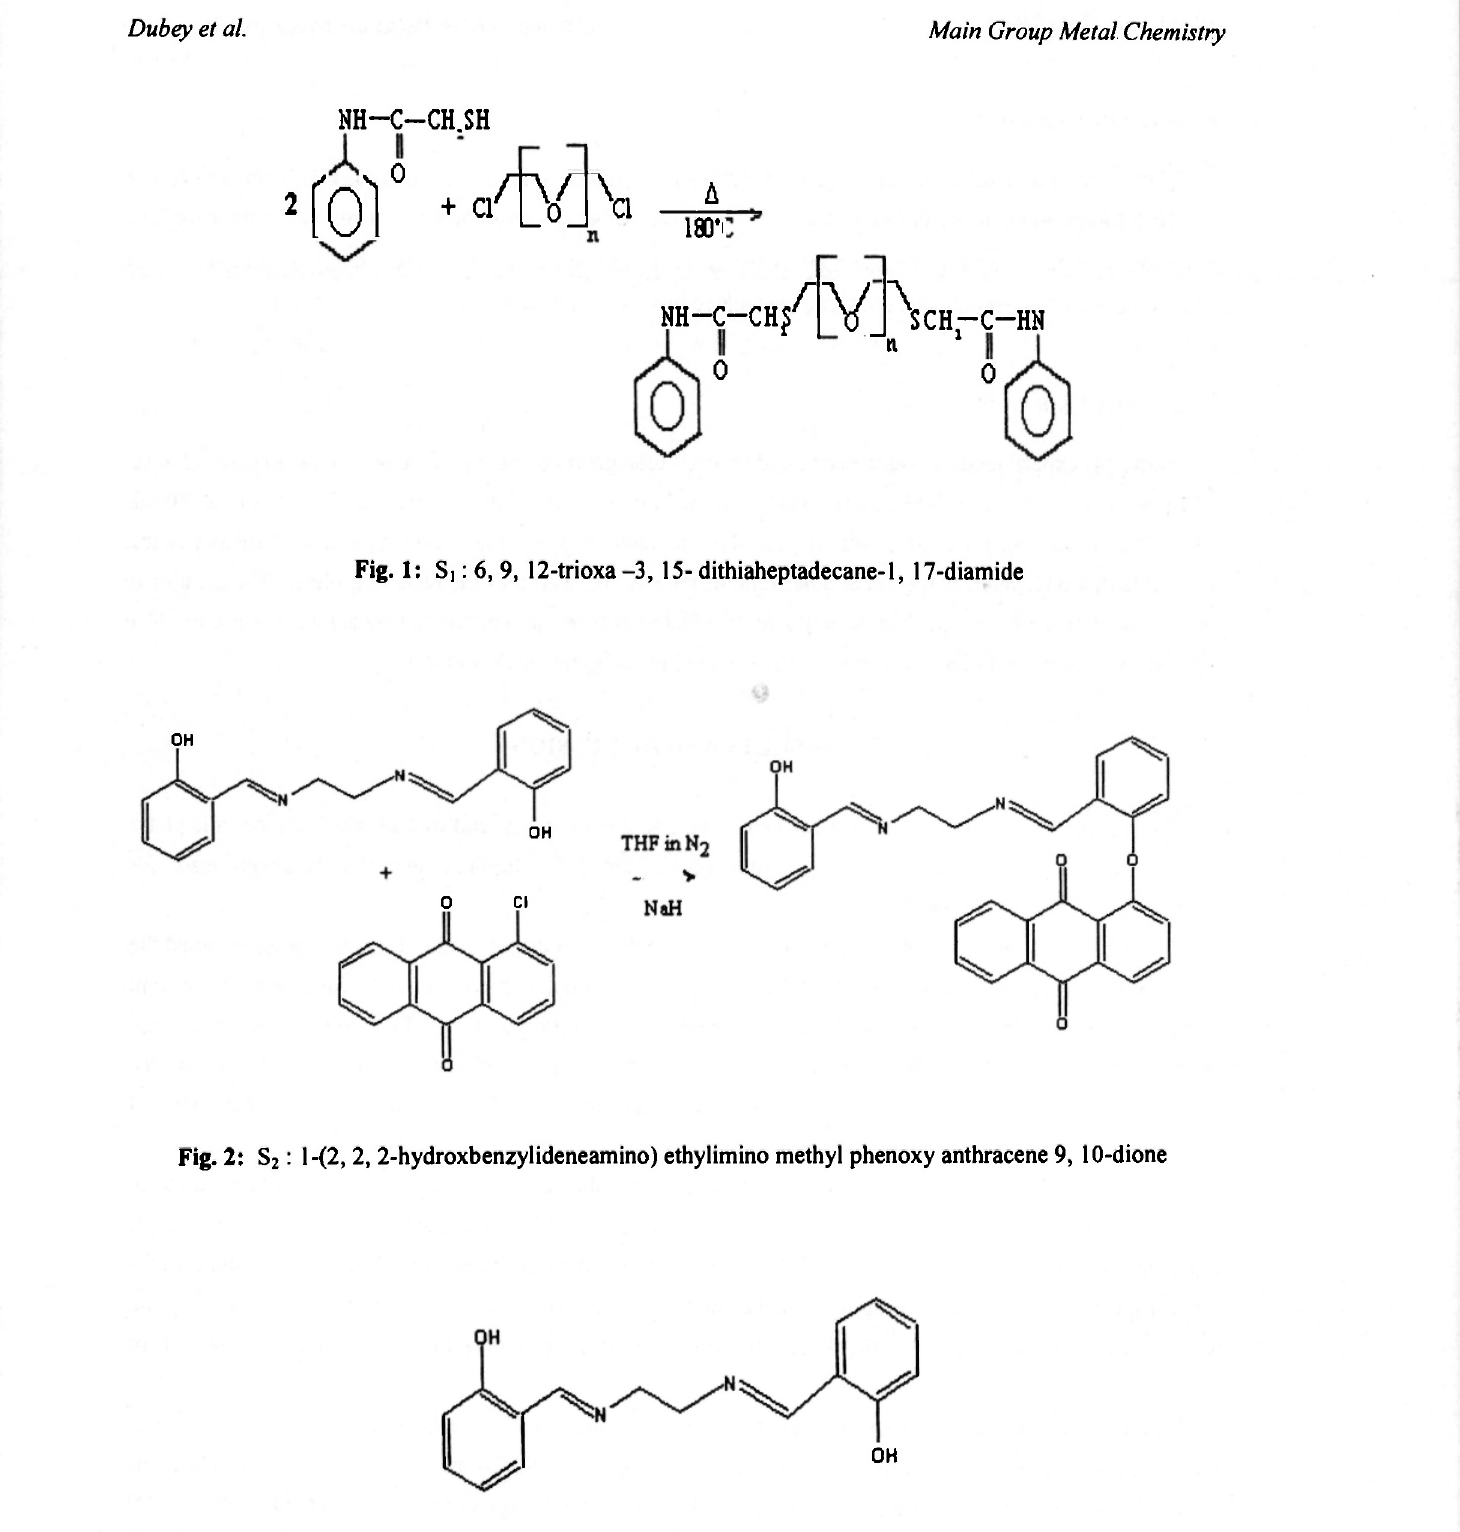
Fig. 3: S 3 : 2,2'(l,r)-(ethane-l,2 diylbis (azan-l-yl-ylidene))bis methanol- 1-yl-l-ylidene)